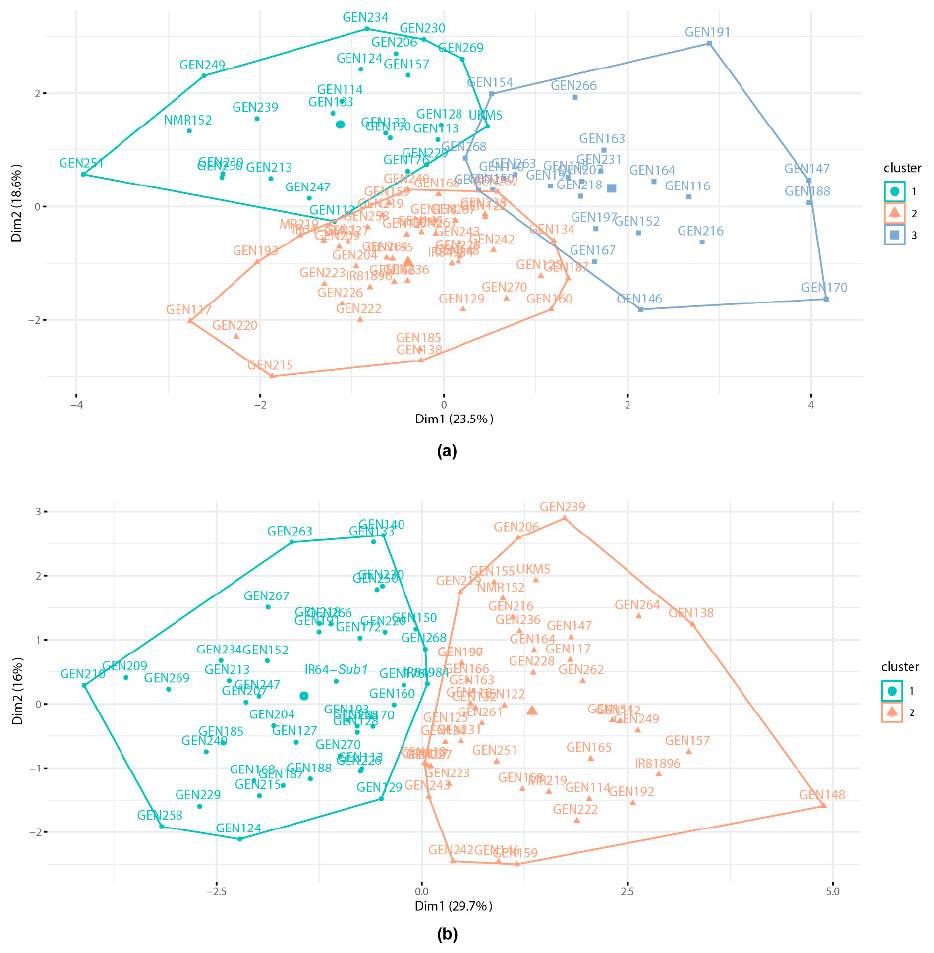
Figure 3 . Cluster plot showing the clustering of genotypes in ( a ) non-stress and ( b ) reproductive stage drought stress trials in 2019MS